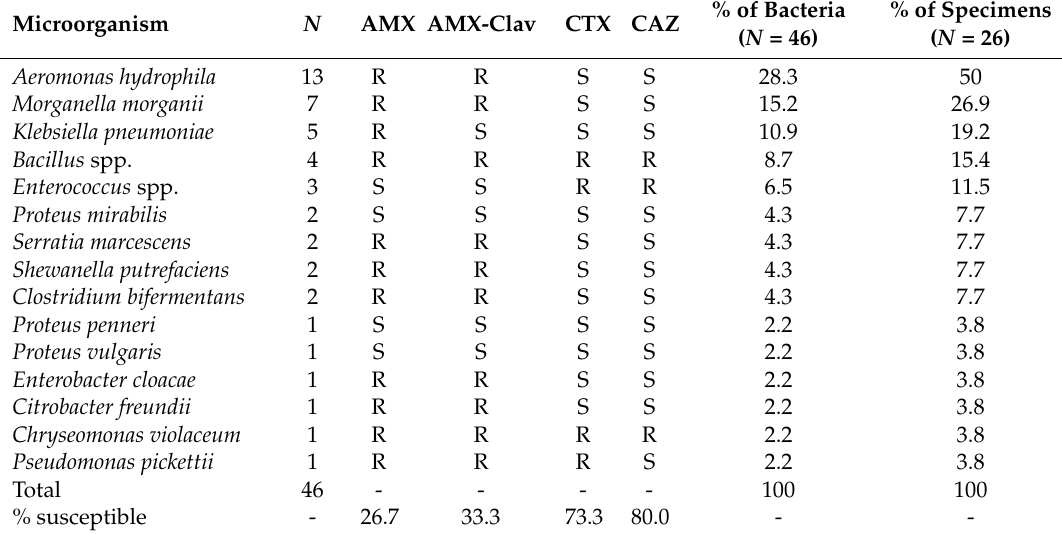
Table 1. Bacteria isolated from the oral cavity of Bothrops lanceolatus in Martinique and their susceptibility to